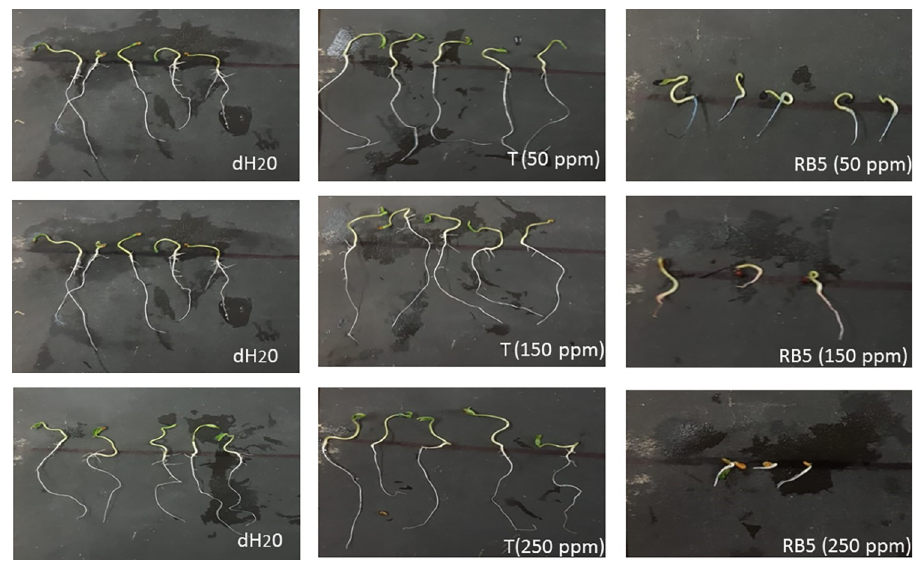
Fig 7. Comparison of phytotoxicity on growth parameter of plant Solanum lycopersicum (Riogrande ). While treating it with various concentrations of reactive black 5, treated reactive orange 5 with ROC (T) and control (dH 2 O).